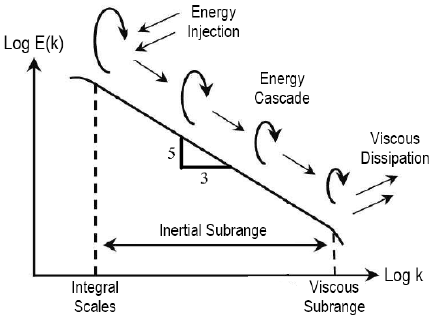
Figure 1. Kolmogorov’s energy cascade